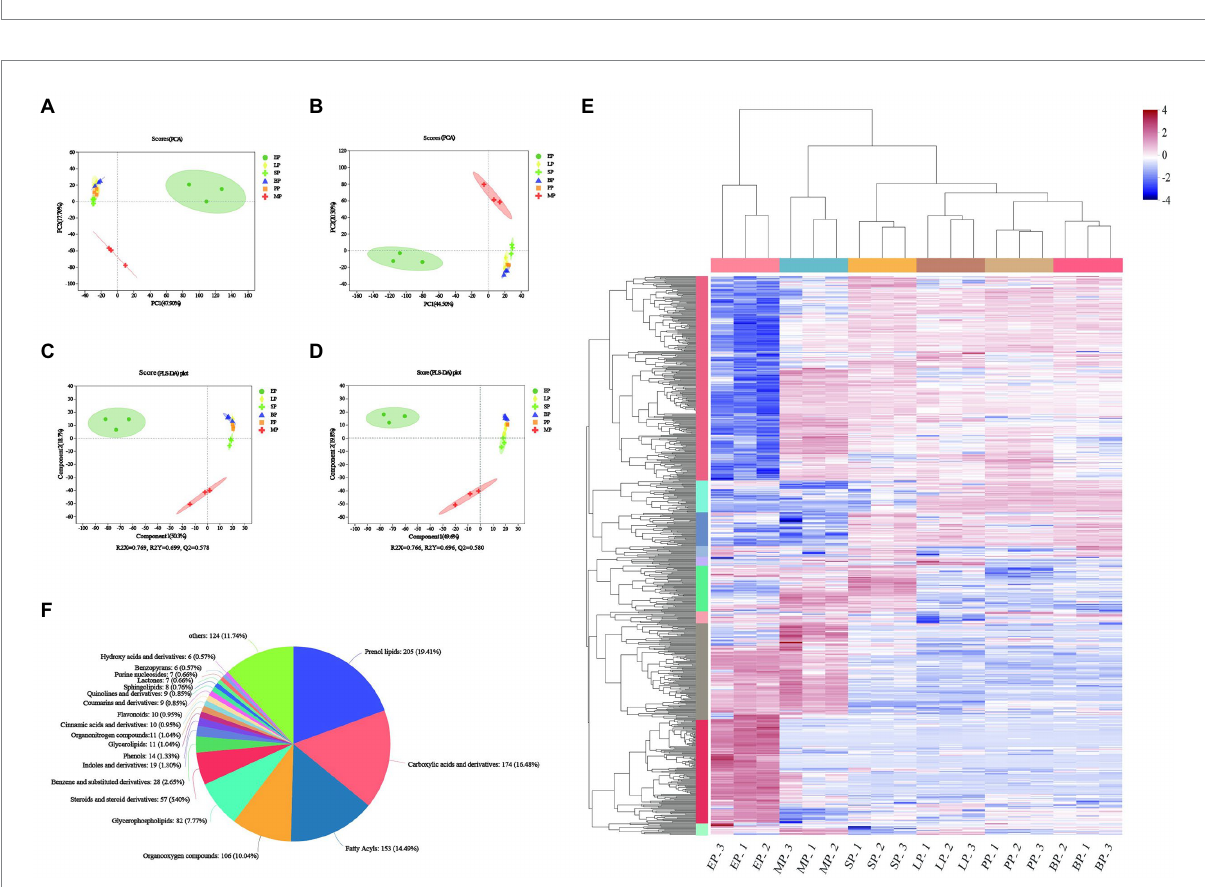
FIGURE 3 Principal component analysis (PCA) for the significantly differentially expressed metabolites (A,B) . Partial least squares discriminant analysis (PLS- DA) for the significantly differentially expressed metabolites (C,D) . Clustering analysis of WG sample (E) ; Classification of all of the detected metabolites. The columns represent 11 groups of WG and each row indicates the same metabolite. The color-coded scale grading from red to blue represents the relative content of metabolites from high to low, respectively (F)